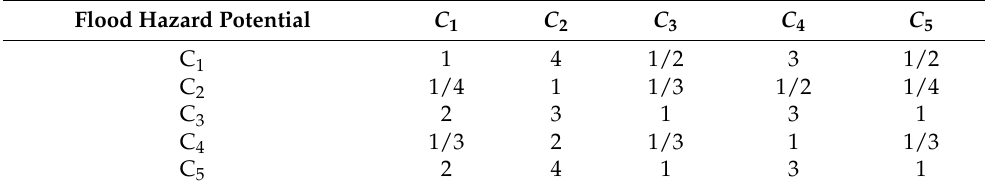
Table 2. The judgment matrix of criteria. C 1 = Slope , C 2 = Elevation , C 3 = Distance from streams , C 4 = Hydro-lithological formations , C 5 = Land use type